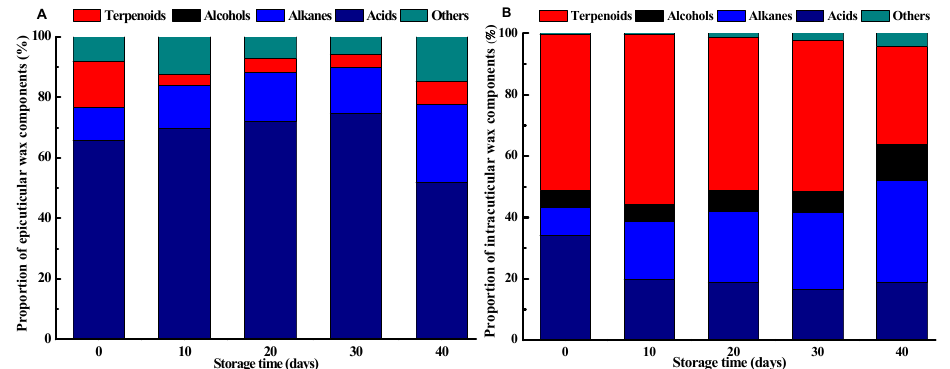
Figure 2. Epicuticular wax components proportion ( A ) and intracuticular wax components proportion ( B ) of the ‘Satsuma’ mandarin fruits during storage.